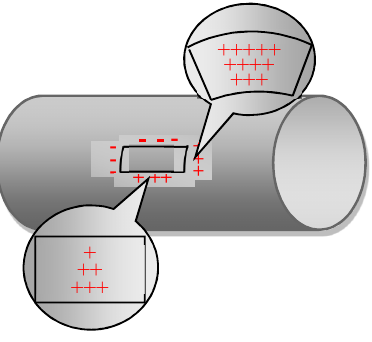
Figure 1. Schematic diagram of pipeline crack magnetic charge model.